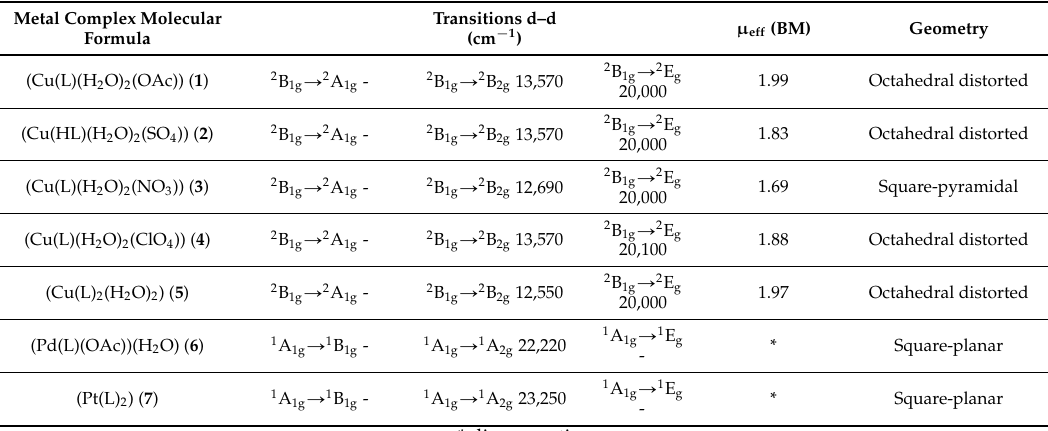
Table 1. Electronic spectra (cm ´ 1 ) and magnetic moment (BM) of the complexes 1 – 7 . Metal Complex Molecular